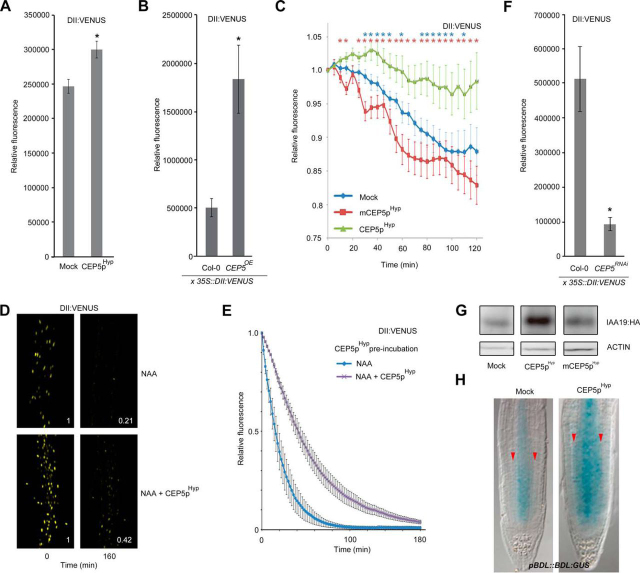
CEP5 impacts AUX/IAA levels.A–B, Relative DII:VENUS protein fluorescence in 35S::DII:VENUS reporter line following 18 h incubation with 5 μm CEP5pHyp compared with mock treatment at 5–6 days after germination (n ≥ 83) (A) and Col-0 and a CEP5OE line at 5–6 days after germination (n ≥ 15) (B). C, DII:VENUS levels upon treatment with CEP5pHyp, mCEP5pHyp or mock for 120 min (n ≥ 4). Graph shows average ± standard error. *, p < 0.05 according to Student's t test compared with mock (blue) or mCEP5pHyp (red). With respect to mock versus mCEP5pHyp there was - apart from 15, 30 and 55 min (p < 0.05) - no global significant difference. Note: no auxin was used in this experiment. D, Confocal image of DII:VENUS labeled nuclei from the 35S::DII:VENUS reporter line in a section of the root that was used for measuring the DII:VENUS protein fluorescence in seedlings treated for 160 min (with 1 μm NAA or with 1 μm NAA and 5 μm CEP5pHyp). Normalized ratio of average top 500 pixel intensity, compared with 0 min, is indicated. E, DII:VENUS fluorescence level over time (0–180 min) after transfer to 1 μm NAA, with pre-incubation (18 h) and co-incubation with 5 μm CEP5pHyp (n ≥ 4). F, Relative DII:VENUS protein fluorescence in 35S::DII:VENUS reporter line in Col-0 and a CEP5RNAi line at 5–6 days after germination (n ≥ 15). G, Representative Western blotting of IAA19:HA levels (anti-HA) in 10-day old seedlings grown in the presence of 5 μm CEP5pHyp or 5 μm mCEP5pHyp during the whole growth period. Loading control is ACTIN. Note: no auxin was used in this experiment. H, BDL:GUS protein in representative 6-day old pBDL::BDL:GUS root tips after transfer of 4 day old seedlings to mock or 1 μm CEP5pHyp for 2 days. Red arrowhead marks cortex. In A, B and F, graphs show average ± standard error of indicated sample numbers. *, p < 0.05 according to Student's t test compared with mock or Col-0. In all cases, mock refers to medium with water as used to dissolve CEP5pHyp.